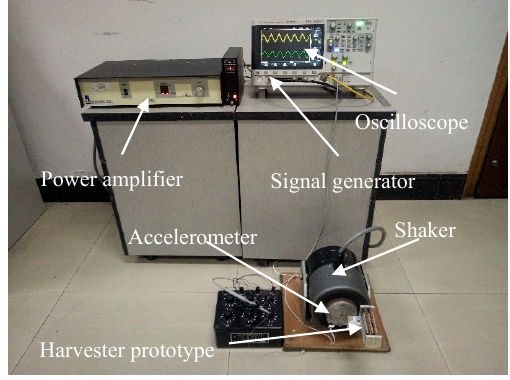
Figure 9. Experimental setup.